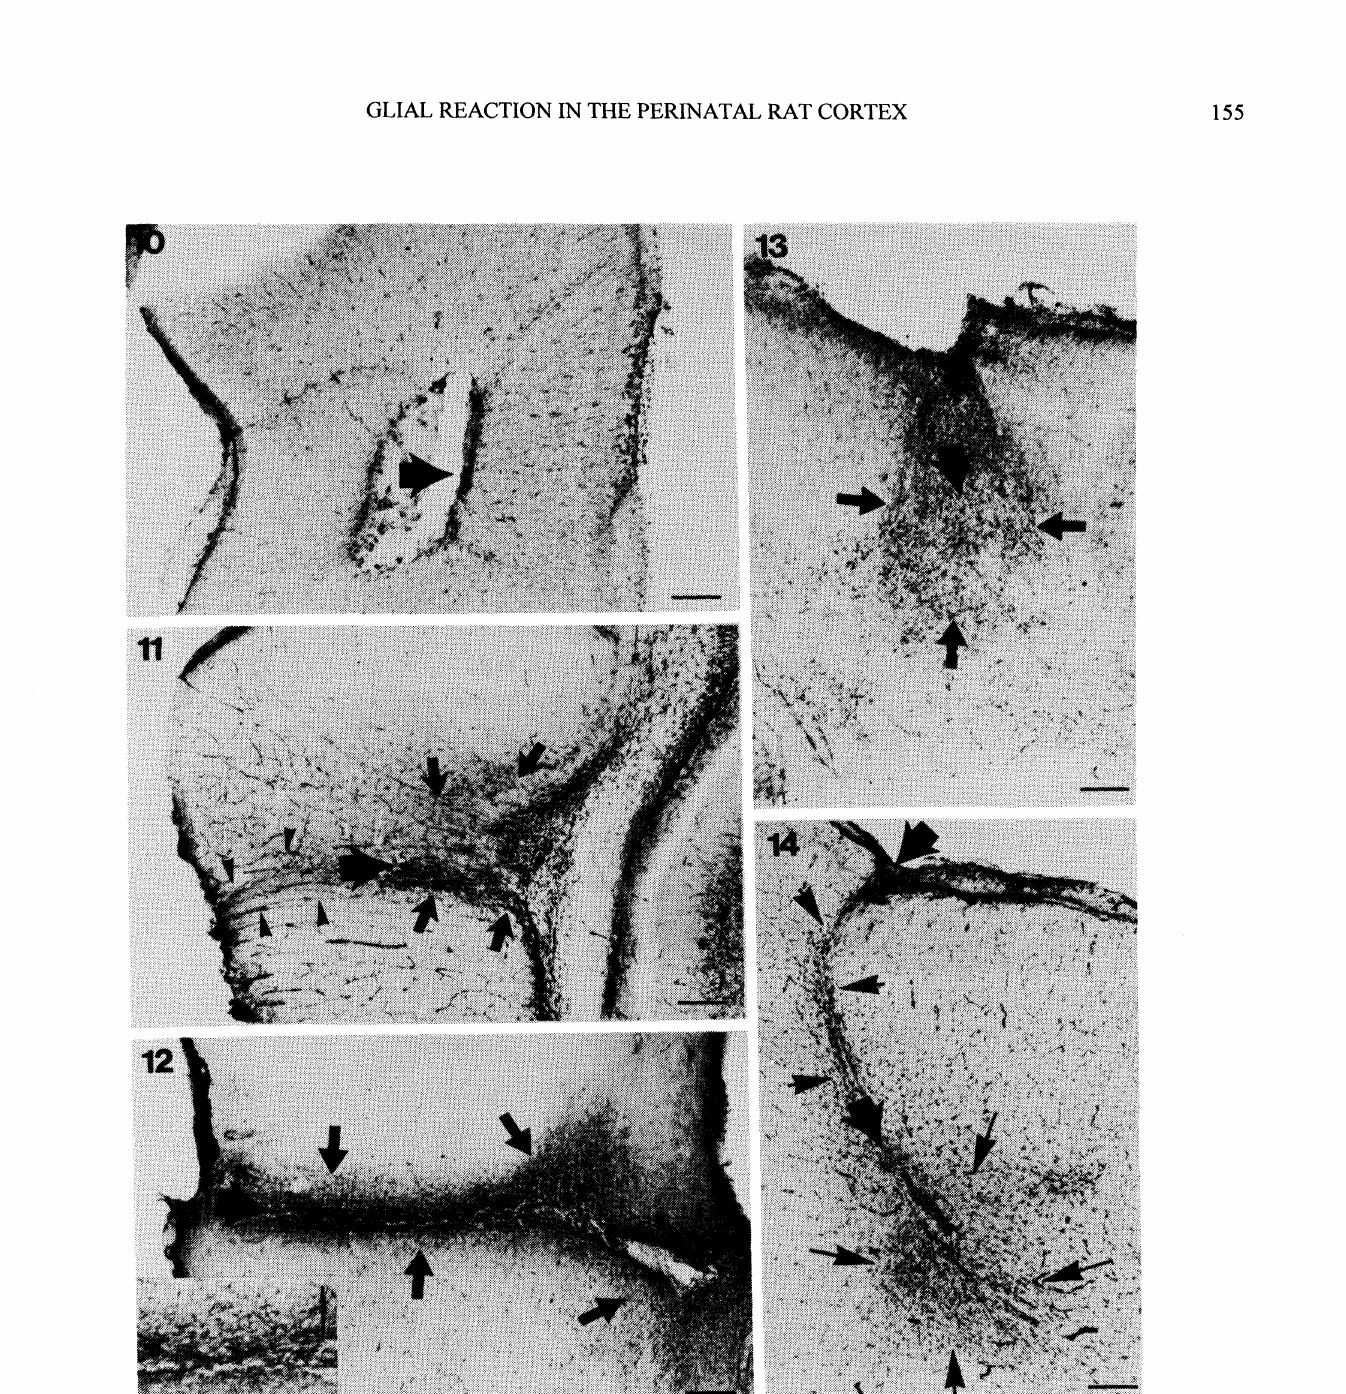
Figs. 10-14: GFAP immunostaining following P4, P5, P6 lesions. (10) Severe-type P4 lesion, post-op d-2. The site of the lesion (thick arrow) is marked by tissue defect but not reactive glia. Bar 250 I.tm. (11) Severe-type P4 lesion, post-op d-3, The deeper part of the lesion (thick arrow) is surrounded by reactive glia (arrows), whereas the superficial part (arrowheads) is not. Bar 250 l.tm. (12) Severe-type P4 lesion, post-op d-4. Strong glial reaction (arrows)can be observed along the entire length ofthe lesion (thick arrow). Inset shows enlarged detail ofthe lesion. Bar 250 l.tm, inset bar 120 t.tm. (13) Severe-type P5 lesion, post-op d-2. A weak glial reaction (arrows) is present around the lesion (thick arrow). Bar 150 lam. (14) Severe-type P6 lesion, post-op d-4. The entire lesion (thick arrow) is surrounded by reactive glia (arrows), but its intensity decreases near the surface of the cortex (short arrows). Bar 150